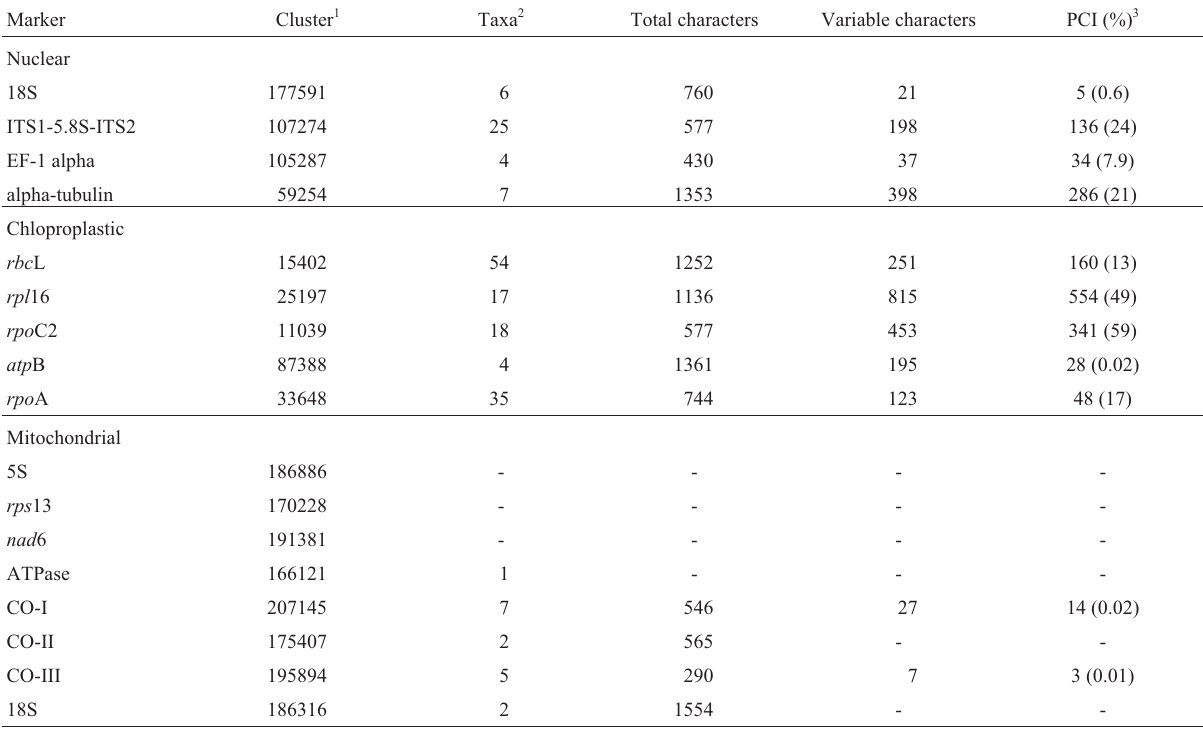
Table III - Phylogenetic information of sugarcane evolution markers.